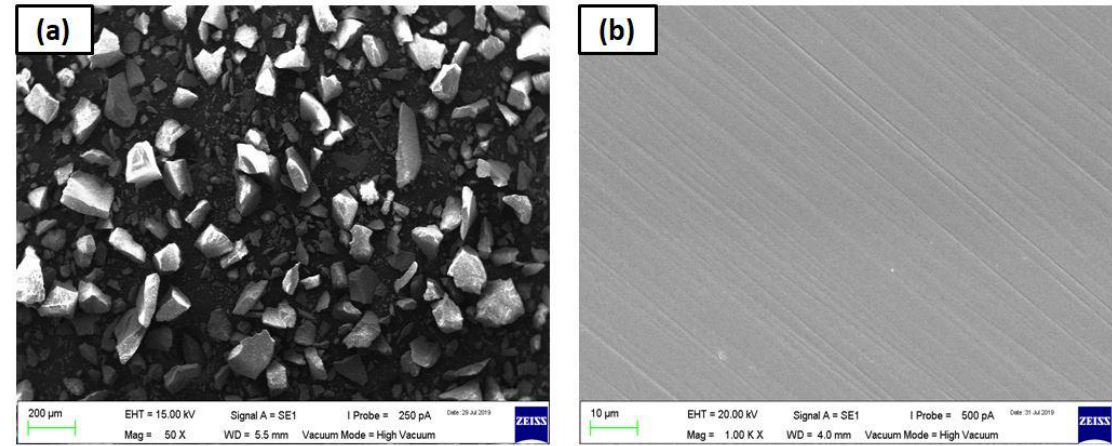
Figure 2. Microscopic images of: ( a ) silica sand, and ( b ) polished 1018 carbon steel (CS).